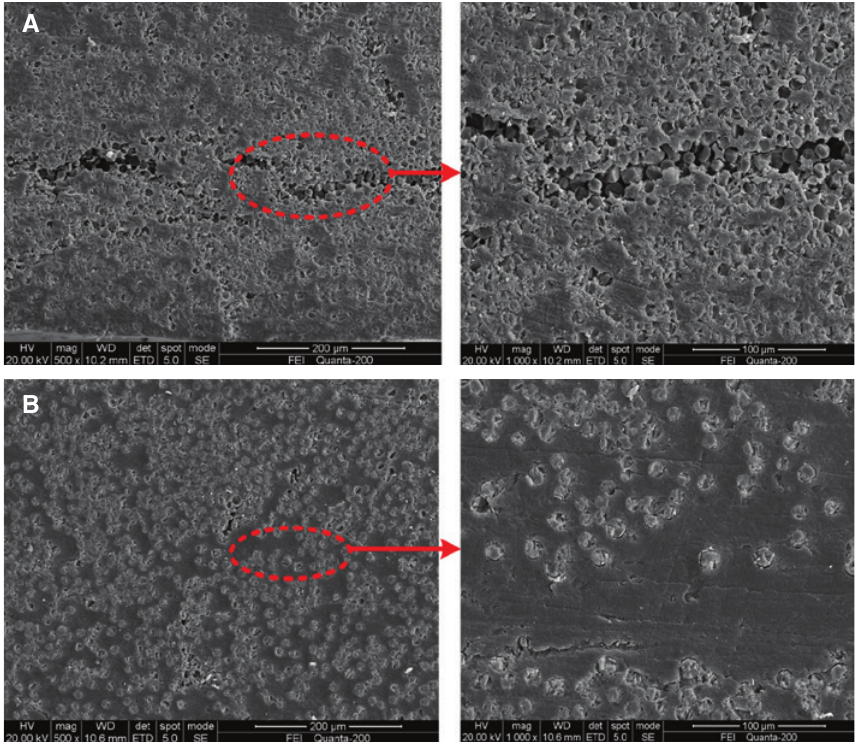
modified GFRP. 2